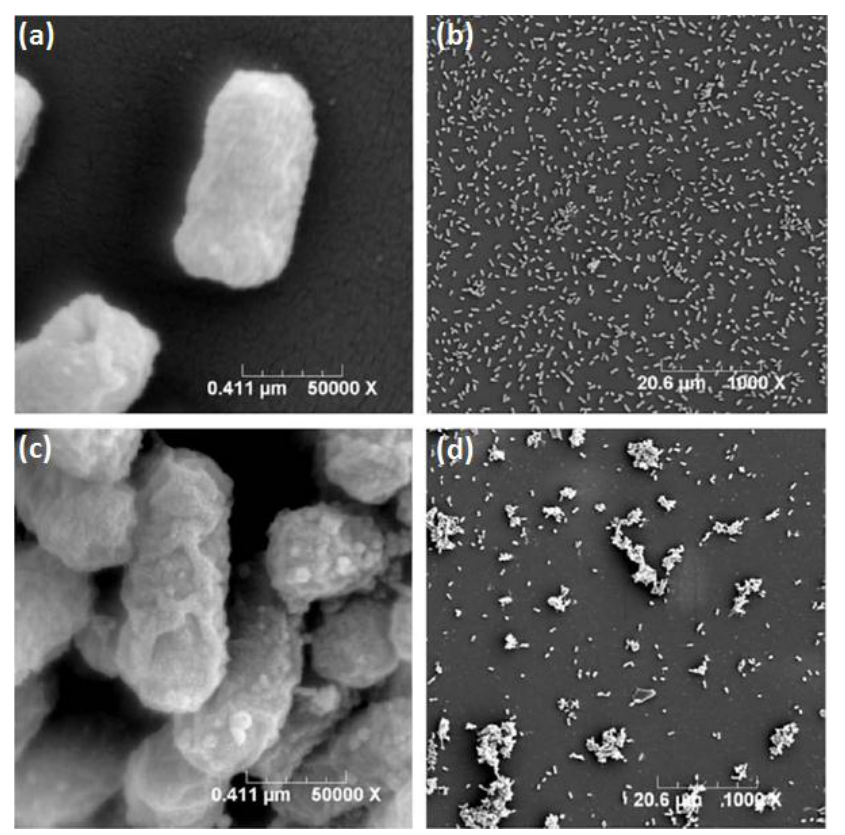
Figure 1. SEM images of E. coli after incubation with 100 mg L −1 chitosan/arginine (CHT/ARG) for 3 h. Controls ( a – d ); cells treated with 6%-substituted CHT/ARG ( b ) and cells treated with 30%-substituted CHT/ARG ( c ). Reprinted with permission from reference [44]. Copyright 2010